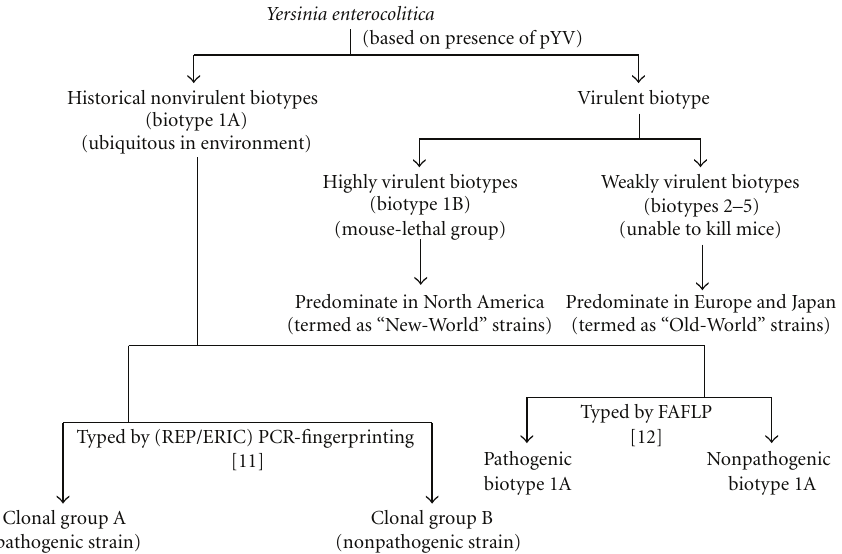
Figure 2: Y. enterocolitica biotypes. Y. enterocolitica biotypes are classified into three distinct group: a historically defined nonpathogenic group (biogroup 1A); a weakly pathogenic group that are unable to kill mice (biogroups 2 to 5); a highly pathogenic, mouse-lethal group (biogroup 1B). Biotype 1A strains are clustered into two clonal groups (A and B) when typed by repetitive extragenic palindrome (REP)— and enterobacterial repetitive intergenic consensus (ERIC)—PCR fingerprinting [11], and two groups when typed by fluorescent amplified fragment length polymorphism (FAFLP)